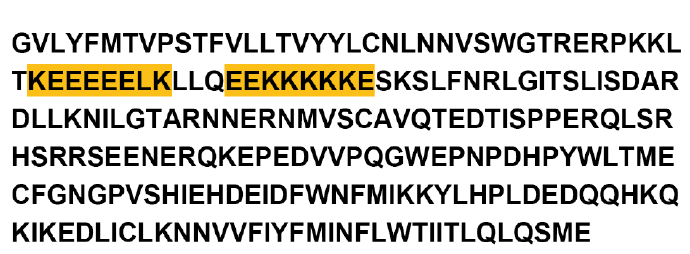
Figure 1. Partial sequence encoding an extracellular domain of Ar -CS1, the myocin chitin synthase of the bivalve Atrina rigida